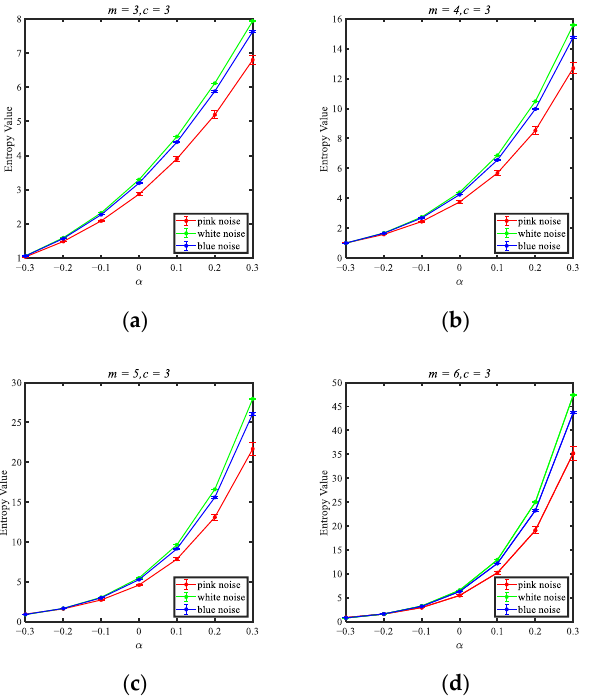
Figure 3. Means and standard deviations of different embedding dimensions 𝑚 at different fractional orders. ( a ) 𝑚 = 3; ( b ) 𝑚 = 4; ( c ) 𝑚 = 5; ( d ) 𝑚 = 6